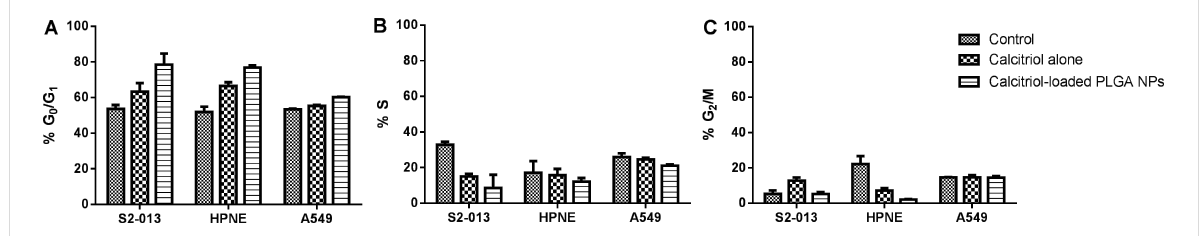
Figure 6: Cell cycle distribution of S2-013, hTERT-HPNE and A549 cells treated for 72 h with free calcitriol and calcitriol entrapped in PLGA NPs. The graphs show the percentage of cells in (A) G 0 /G 1 , (B) S and (Cc) G 2 /M phases. The data is represented as the mean ± SD ( n = 3).